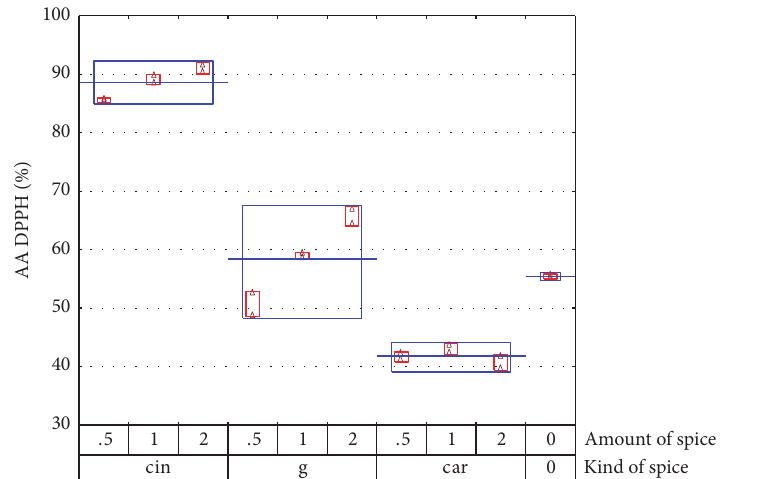
Figure 3: Average AA DPPH in honey samples with addition of different quantities of different spices (cin: cinnamon, g: ginger, and car: cardamom). Source: own